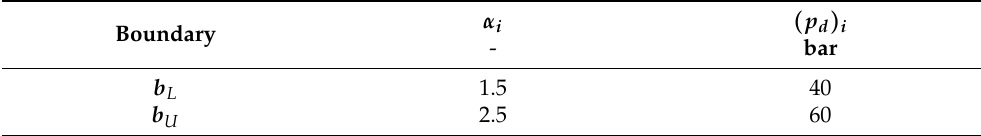
Table 2. Design parameters’ ranges.